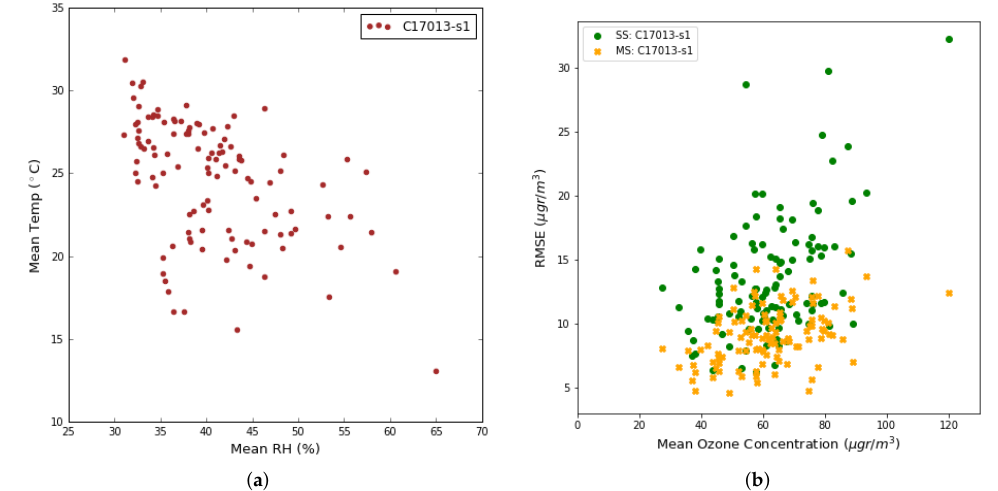
Figure 14. ( a ) Average temperature versus average relative humidity in a per day basis, ( b ) Test RMSE versus average ozone concentrations in a per day